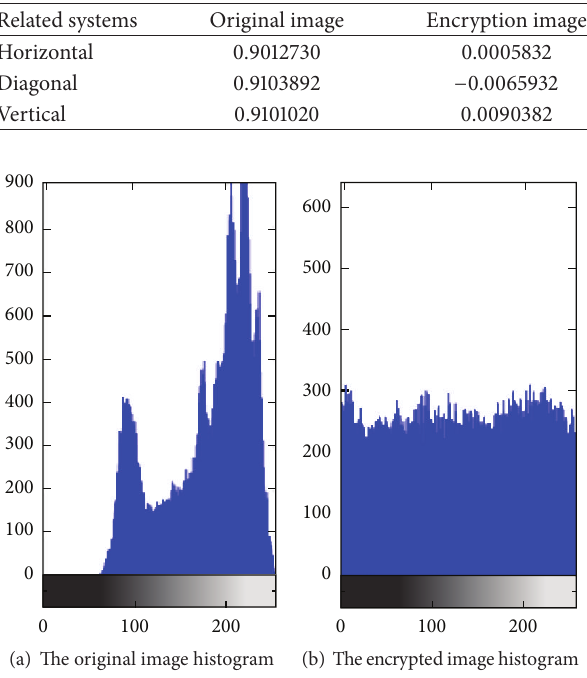
Table 6: The correlation among adjacent pixels of B component.